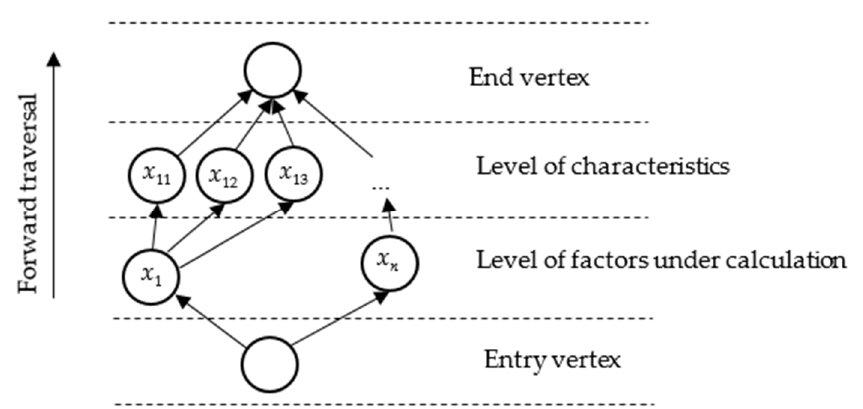
Figure 8. In this algorithm, the variable “flag” is used, which adopts the value “false” if all descendant nodes of the current node are calculated (the calculation of the current node is only initiated in this case).